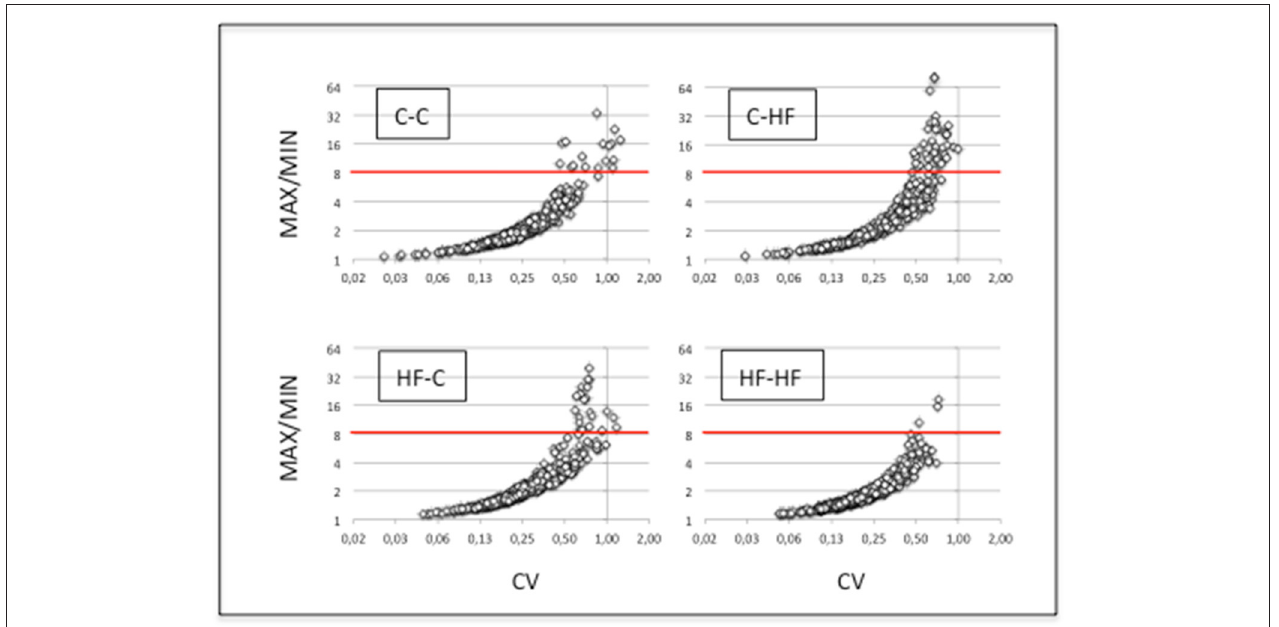
FIGURE 4 | miRNA expression displays high intra-group homogeneity. We characterized complex populations of some 400 miRNAs. In each group and for each miRNA, we analyzed the variation of expression between the six profiles by calculating the maximal to minimal ratio (MAX/MIN) and the standard deviation to mean ratio (coefficient of variation; CV). For each group, scatter plots of MAX/MINs against CVs are drawn. Note that X- and Y-axes used a log 2 scale. Red lines identify the threshold value of mean + 2 STD in group C-C (i.e., 8.3). More than 94% of the miRNAs displayed close MAX/MINs and/or CVs in each group indicative of extensive intra-group homogeneity of miRNA